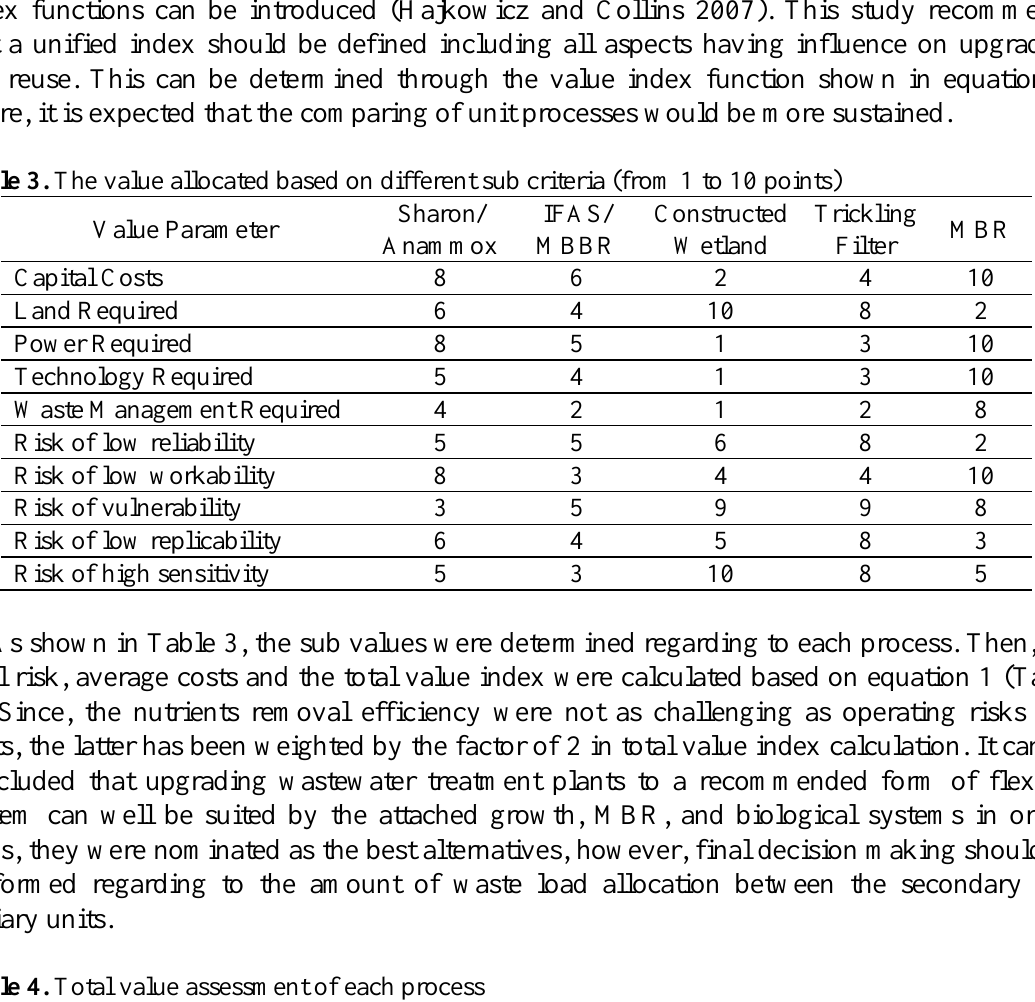
Sharon/ IFAS/ Constructed Anammox MBBR Wetland